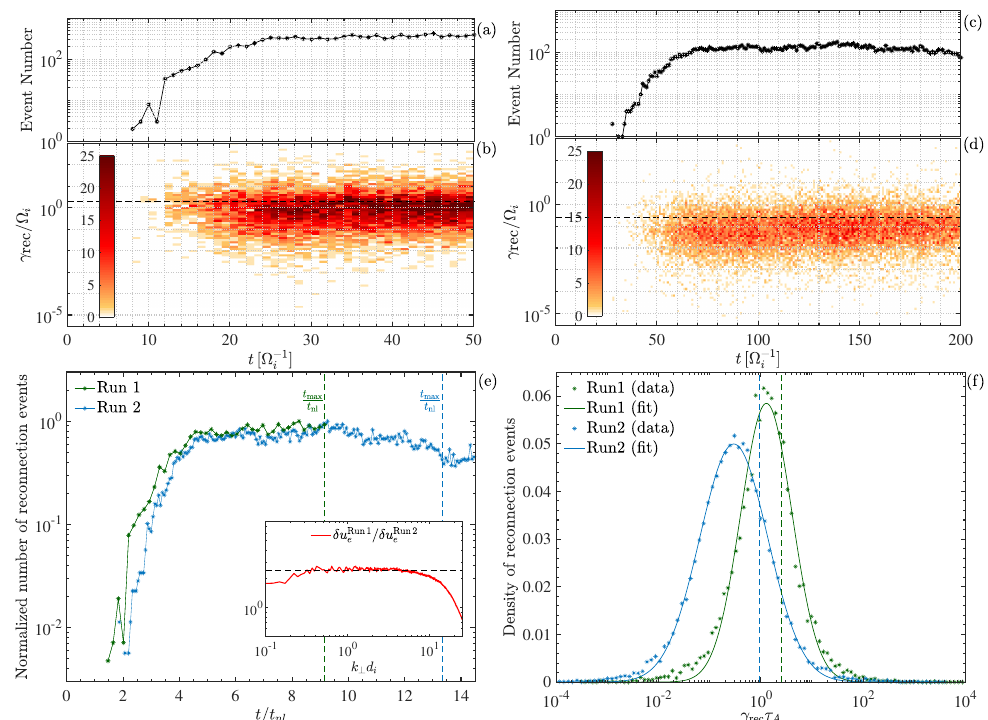
Figure 6. Overview of the time evolution of the properties of magnetic reconnection events: ( a , b ) num- ber of reconnection events in the simulation box and their distribution in terms of the reconnection rate, γ rec , at each time during the evolution for Run 1 (the vertical dashed line marks the average recon- nection rate); ( c , d ) same as panels ( a , b ) but for Run 2; ( e ) number of reconnection events normalised to their maximum values versus the time normalised to the nonlinear time for the two simulations; ( f ) distribution of reconnection rates at the time of maximum turbulent activity for the two simulations, normalised to their local Alfvén time τ A (the vertical dashed lines mark the average